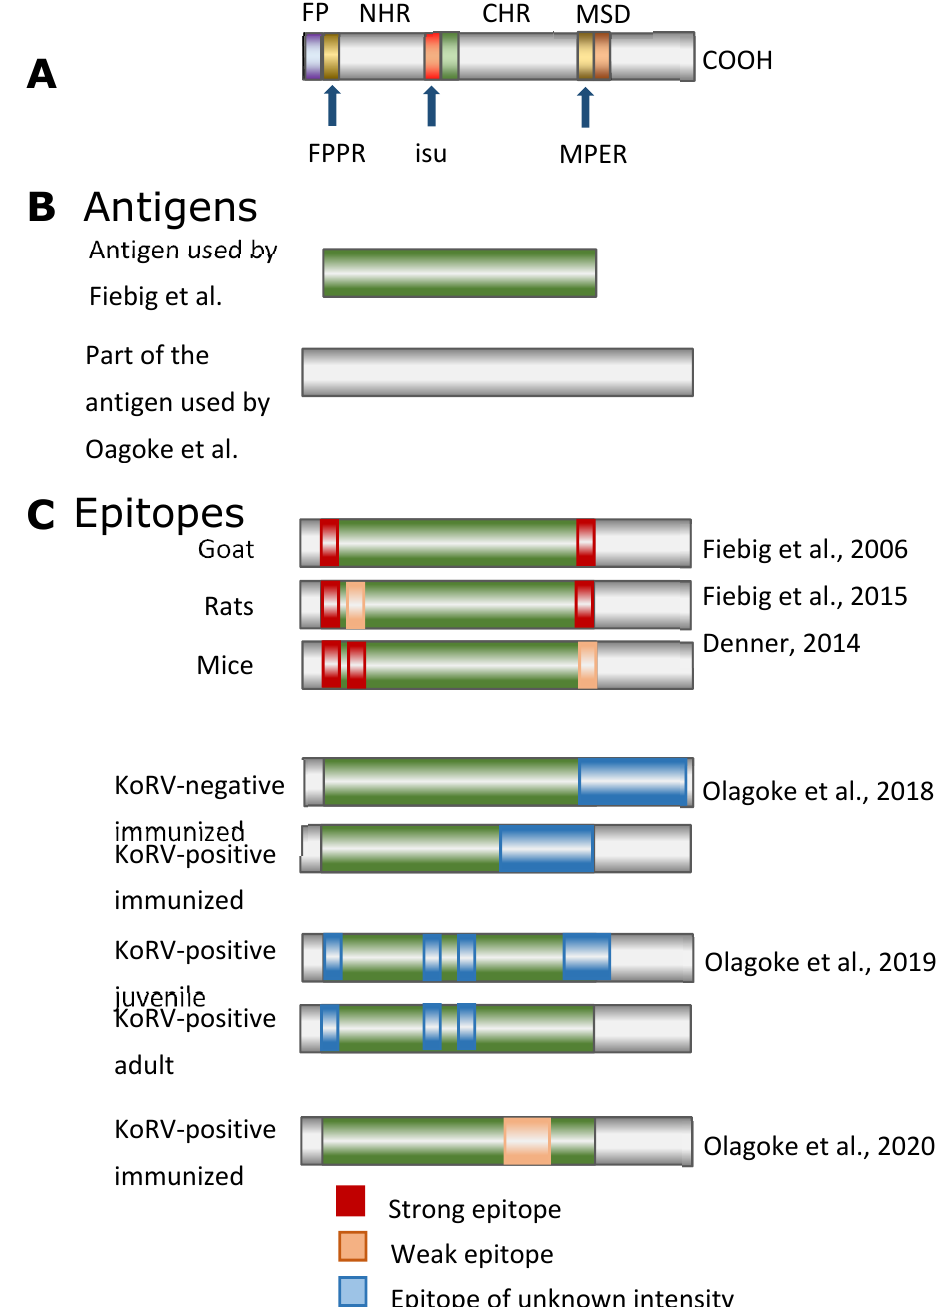
Figure 2. ( A ), Schematic presentation of the transmembrane envelope protein, the relevant domains are indicated (see Figure 1). ( B ), Antigens used for immunization. Top (green): antigen (ectodomain of the TM envelope protein) used by Fiebig et al. [29,36], reviewed in [37]; bottom (grey): antigen (part of the precursor envelope protein) used by Olagoke et al. [33–35]. ( C ), Localization of the epitopes recognized by antisera obtained after immunization with the above-mentioned antigens. The animals and the publications are indicated.